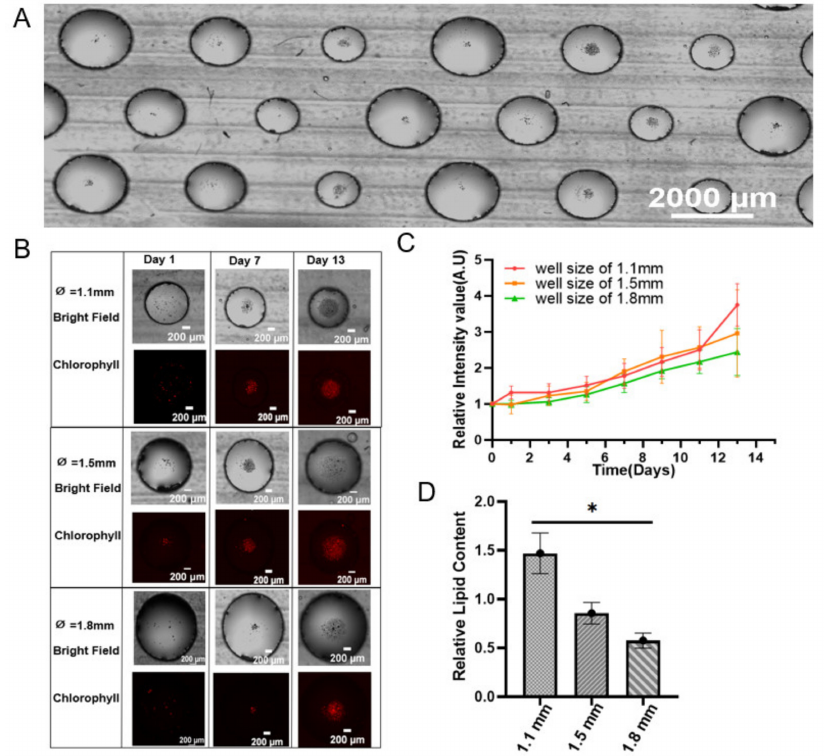
Figure 2. The microalgae cultured in the chip with three well diameters. ( A ) Bright-field image showing the formation of algal cell aggregated on a chip within the wells of sizes 1.1, 1.5 and 1.8 mm on its seventh day of culture. ( B ) Representative time-lapse bright field and chlorophyll ( λ = 645 nm) images showing the increased cell count (day 1, day 7 and day 13); the cell aggregations were observed. ( C ) Growth curve measured using the value of total chlorophyll intensity at wavelength 645 nm. ( D ) Quantification analysis of lipid content in wells of varied diameter (* indicated p -value < 0.05, n =